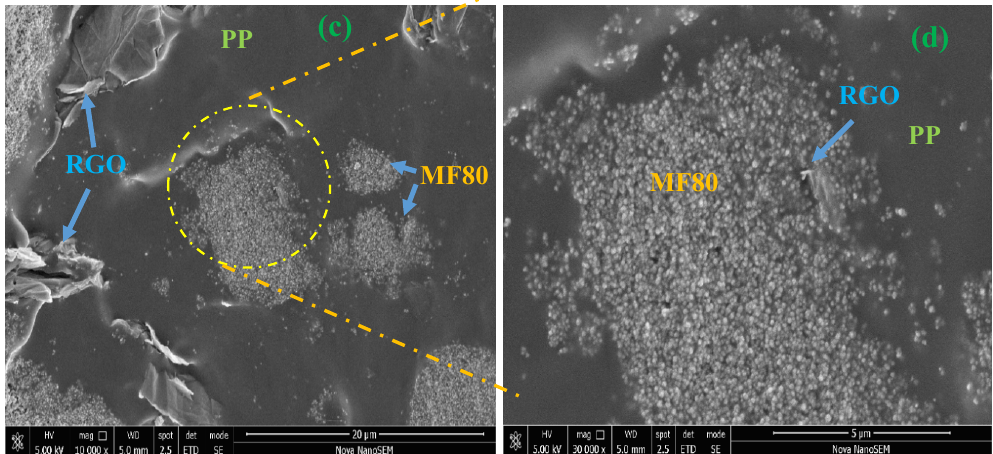
Figure 5. ( a,b ) FE-SEM image of cross-sections of the MF60-RGO-PP sample and ( c , d ) FE-SEM image of cross-sections of the MF80-RGO-PP sample.